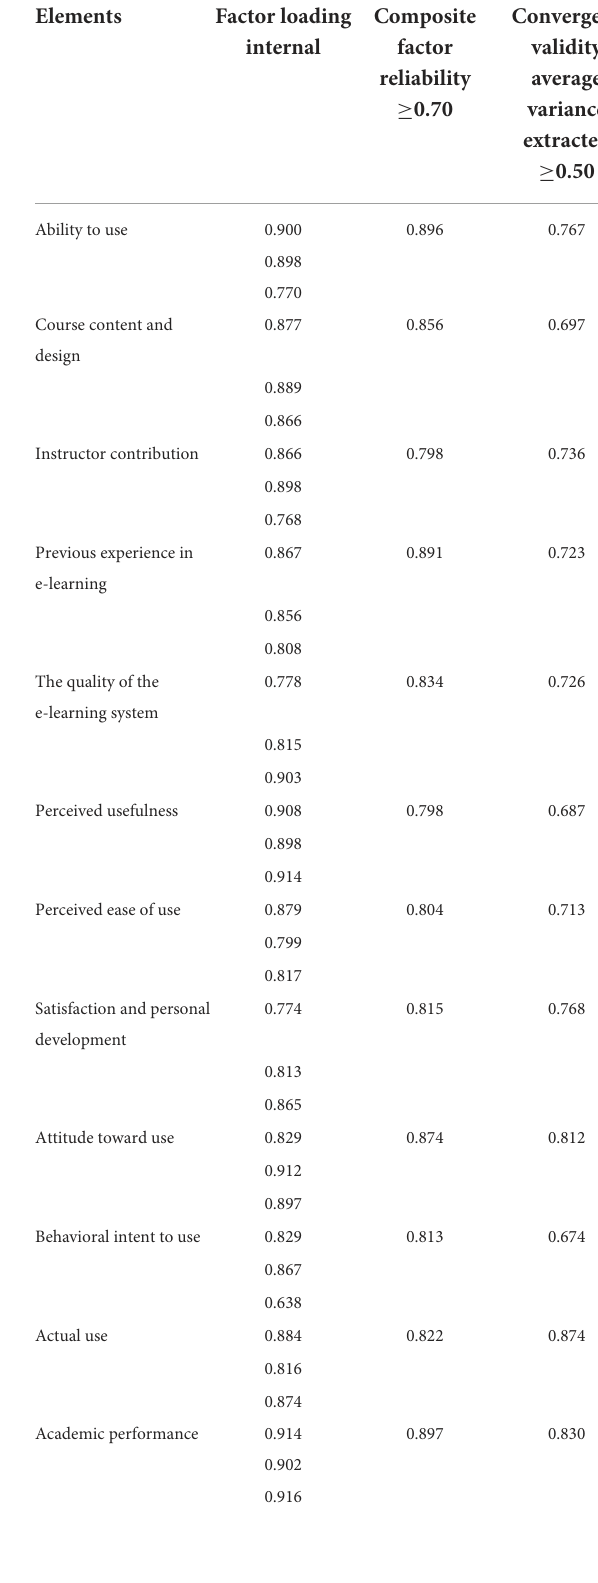
TABLE 2 Demographic results regarding the teachers involved in the study.